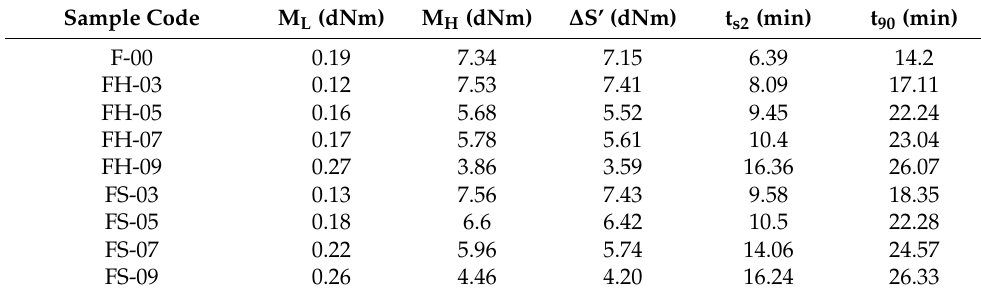
Figure 5. Cure curve of natural rubber compound at various compositions. Table 6. Cure characteristics of natural rubber compound for various compositions at 150 ◦ C.